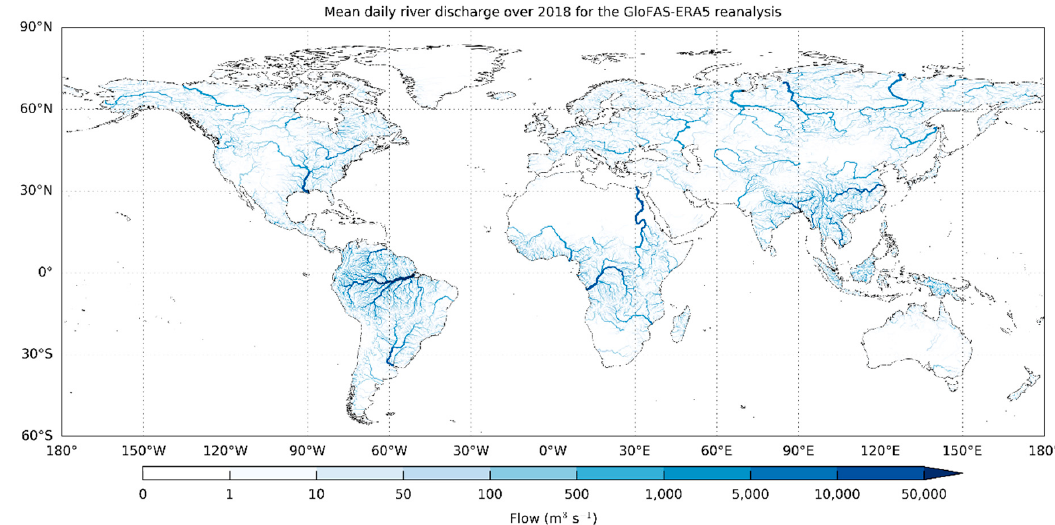
Figure 2. Mean daily river discharge over 2018 for each GloFAS river grid cell with an upstream area greater than 1000 km 2 for the GloFAS-ERA5 river discharge reanalysis. Darker blue river sections have larger river discharge. Data can be freely downloaded from 1979 to (near) real-time from the Copernicus Climate Change Service (C3S) Climate Data Store (CDS): https://cds.climate.copernicus.eu/cdsapp#!/dataset/cems-glofas-historical?tab=overview.